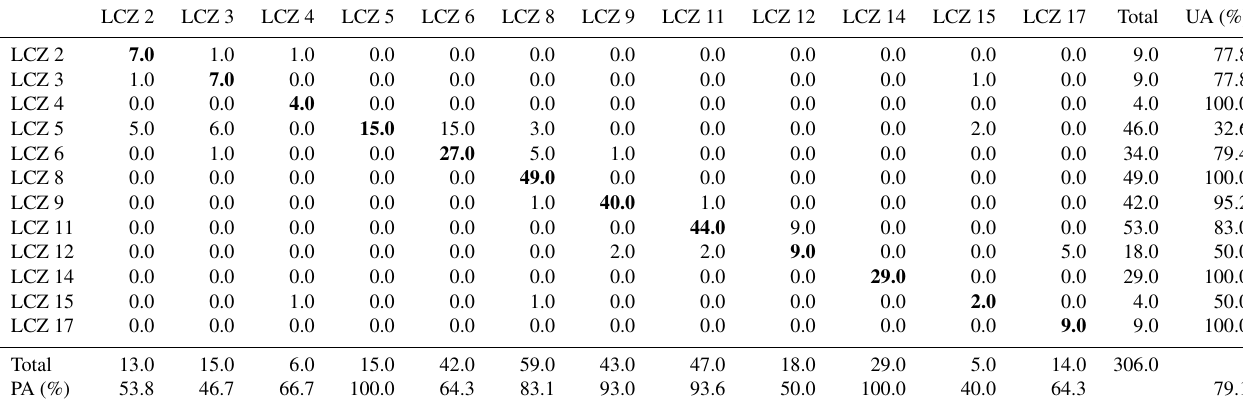
Table B2. Confusion matrix LCZ map. The matrix summarises the number of cells wrongly or correctly classified for each LCZ class. The user accuracy (UA) and producer accuracy (PA) for each LCZ class and the overall accuracy are also included. For each LCZ, the number of cells correctly classified are shown in